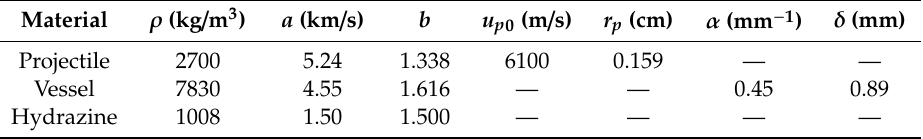
Table 2. Parameters of the projectile, vessel and liquid hydrazine used in